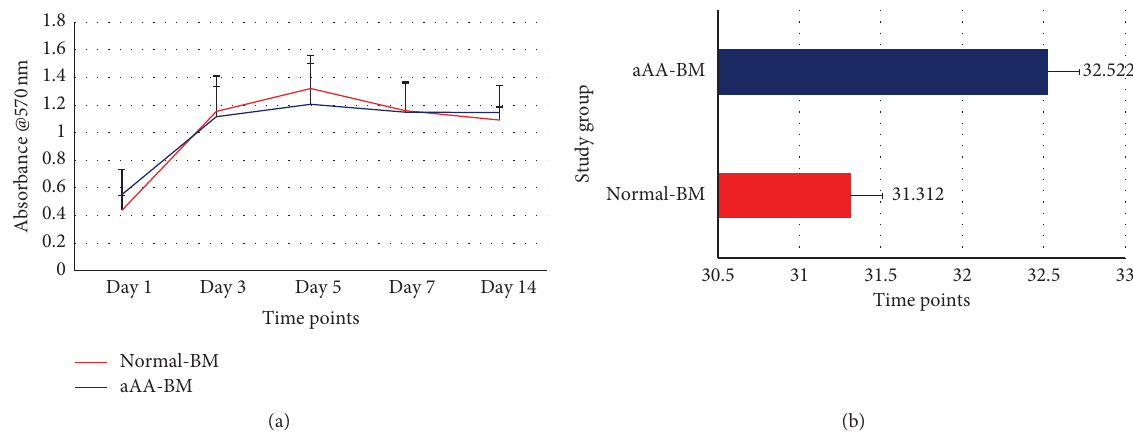
Figure 3: The representative data show the comparison of the proliferative index of aAA-BM and Normal BM. (a) A line graph representing the average metabolic activity of normal BM and aAA-BM ( n � 5 for each group) at different time points. (b) A bar graph representing the comparison of cumulative PD time at passage 3, shown as mean and 95% confidence interval. N � 5.